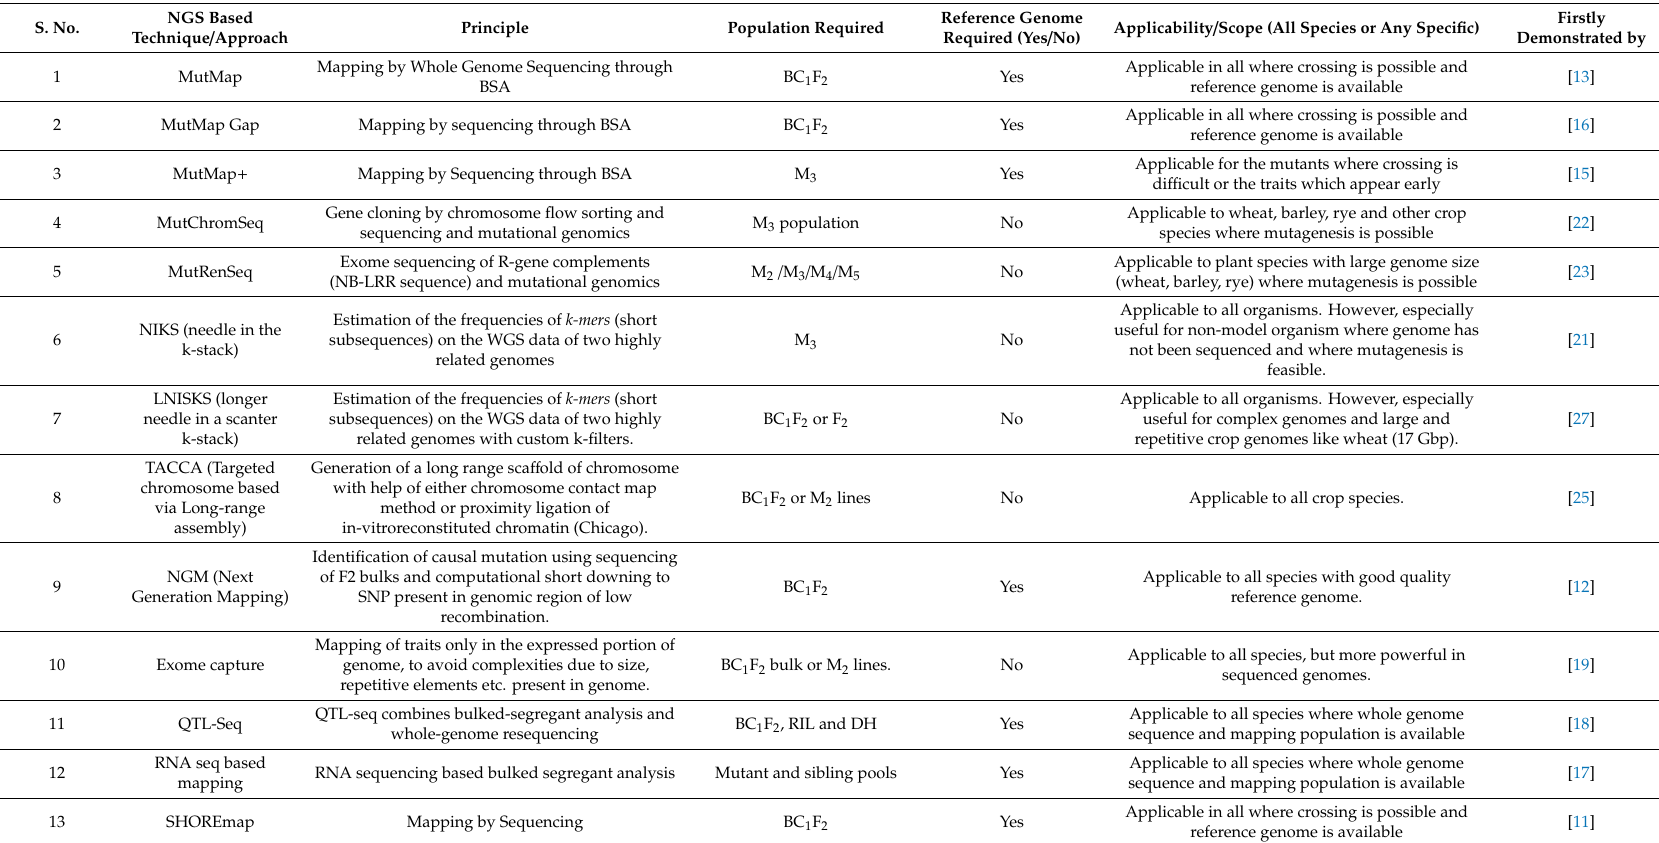
Table 2. Comparisons among the various NGS based forward genetic